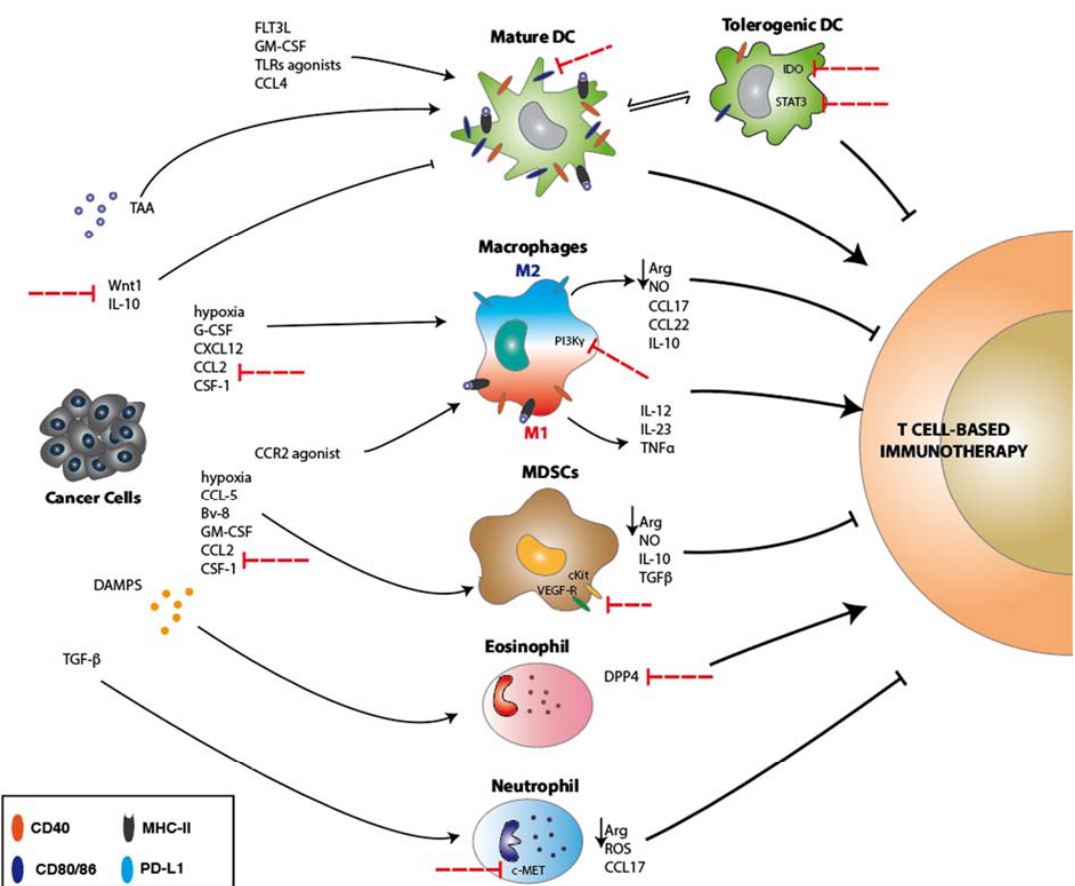
Figure 2. Direct and indirect contribution of innate immune cells in T-cell-based immunotherapy. Innate immune cells can modulate T-cell-based immunotherapy (immune checkpoint blockade (ICB) and adoptive cell therapy (ACT)) through di ff erent mechanisms. Depending on the maturation status DCs can boost or inhibit antitumor T-cell-based functions. Several approaches are aimed to promote DC maturation or to inhibit DC tolerogenic activity. Notably, macrophages show, as DCs, a dichotomous behavior in modulating immunotherapy e ffi cacy. Their role is depending on their phenotype, M1 or M2, and several therapies point to skew the di ff erentiation process towards the more antitumoral M1 phenotype. On the other hand, myeloid-derived suppressor cells (MDSCs) participate in mounting immunosuppression in the tumor microenvironment by releasing di ff erent cytokines and metabolites that inhibit T cell function. Furthermore, granulocytes, like eosinophils and neutrophils, participate in tuning the T cell activity in combination with classical immunotherapies. Some examples of activator or inhibitory molecules produced by innate immune cells are shown. Red dotted arrows indicate relevant therapeutically targeted molecules aiming to boost T-cell-based